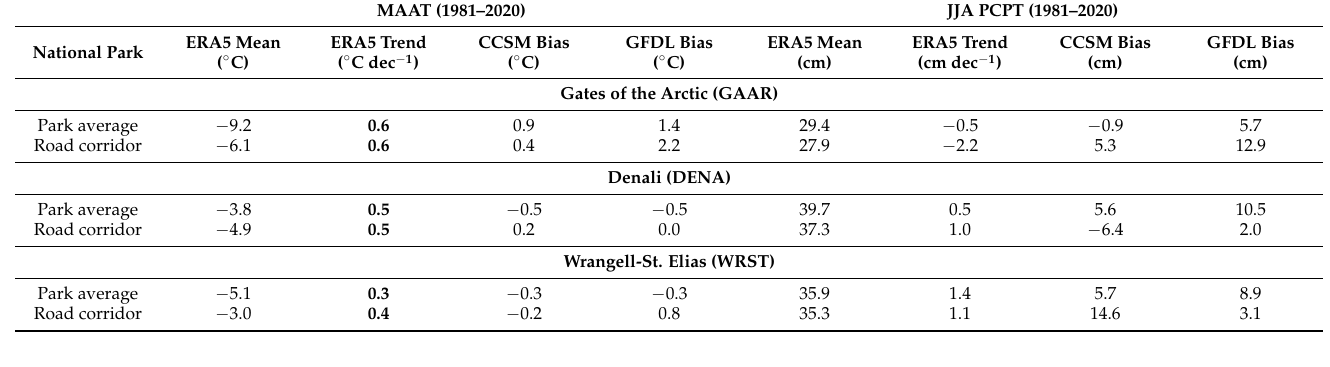
Table 2. Historical mean annual air temperature (MAAT; °C) and summer precipitation (JJA PCPT; cm) from ERA5, CCSM, and GFDL for Gates of the Arctic, Denali, and Wrangell-St. Elias. ERA5 trends of MAAT (°C decade −1 ) and JJA PCPT (cm decade −1 ) are shown with significance at the 95% confidence level in bold.